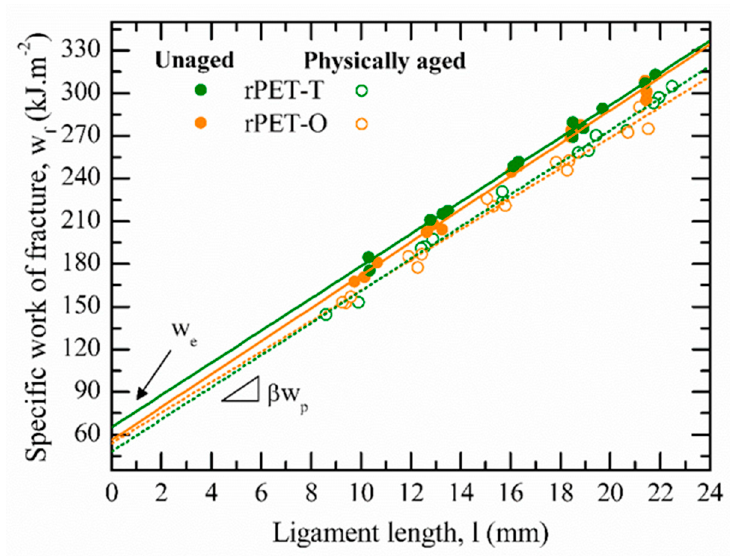
Figure 7. Specific work of fracture as a function of the ligament length for rPET-T and rPET-O materials. The points are experimental data and the lines represent experimental data fits according to Equation (2).